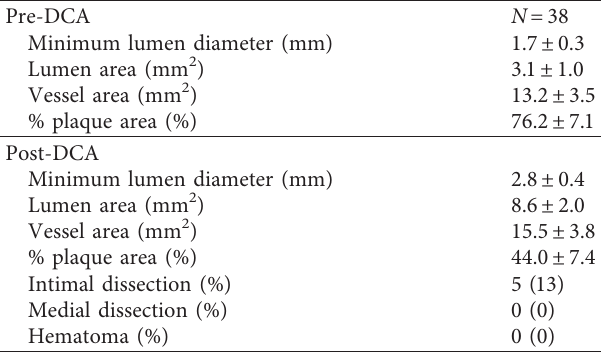
Table 4: Intravascular ultrasound